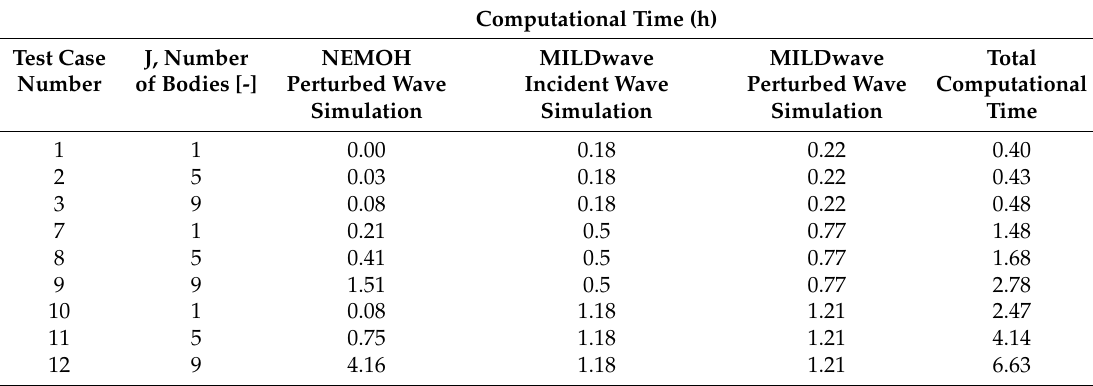
Table 5. Computational Time in hours (h) for the MILDwave-NEMOH coupled model. Computational Time